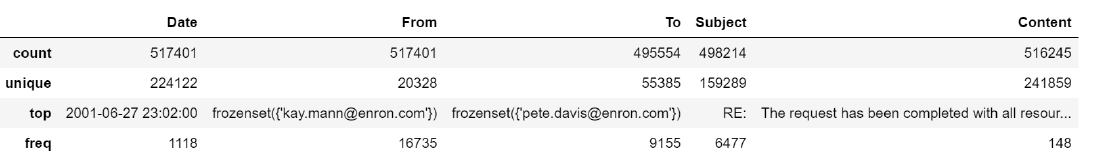
Figure 6. Data understanding.